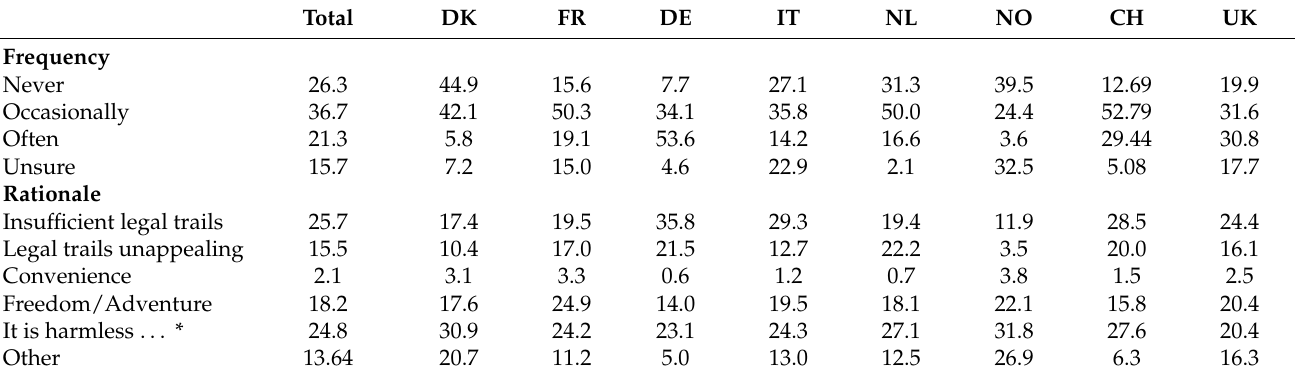
Table 4. Frequency and rationale for riding unauthorised trails (n =